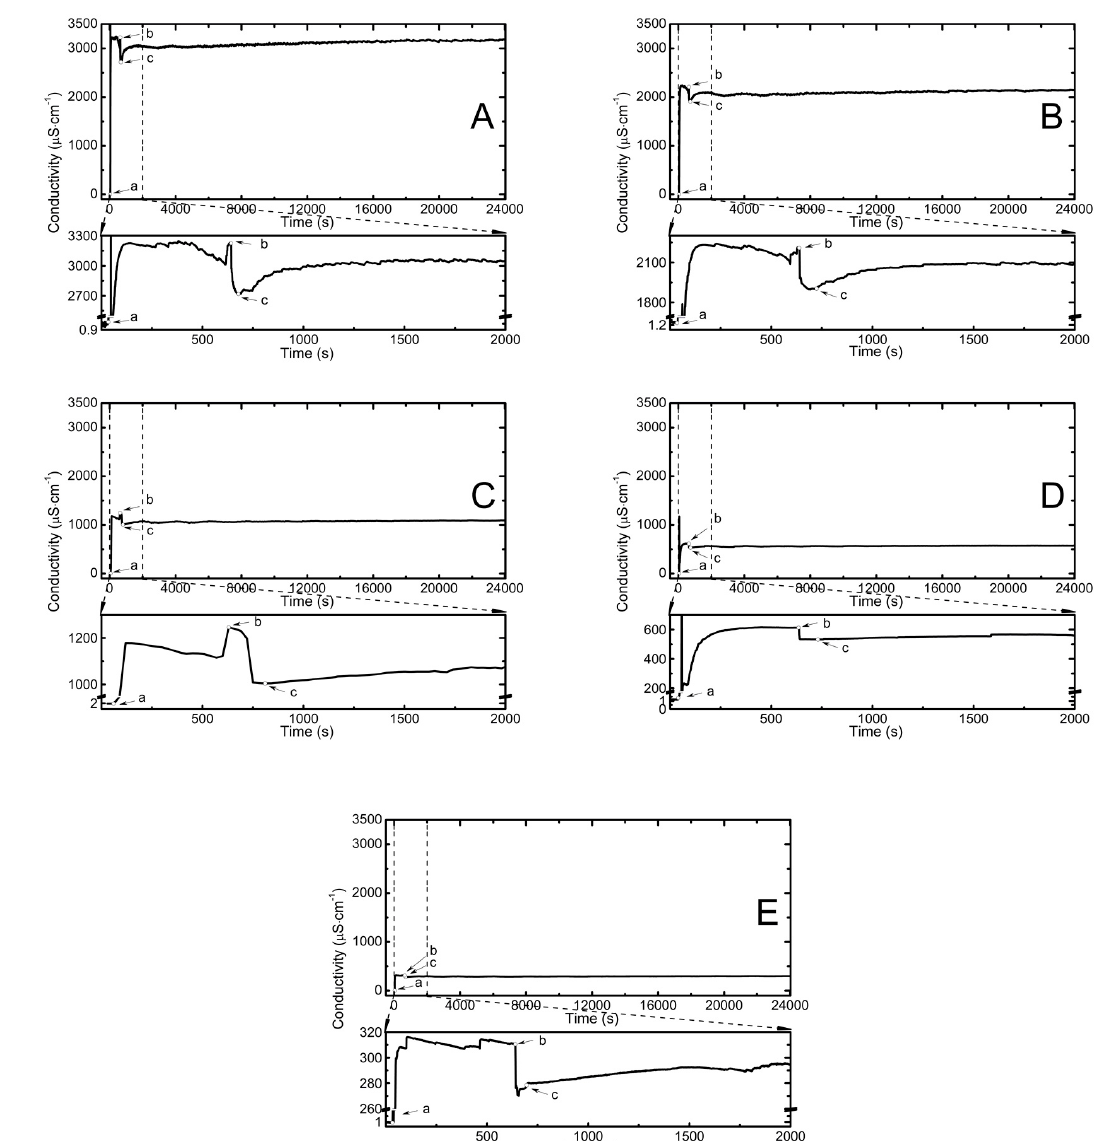
Figure 2. Dependence of conductivity in function of time in reaction mixtures of P1 ( A ), P2 ( B ), P3 ( C ), P4 ( D ), and P5 ( E ) in the course of the polymerization reaction at T = 70 ° C. Point (a) indicates the addition of an initiator, point (b) indicated the addition of the aqueous solution of the monomer, and point (c) indicated the beginning of turbidity.